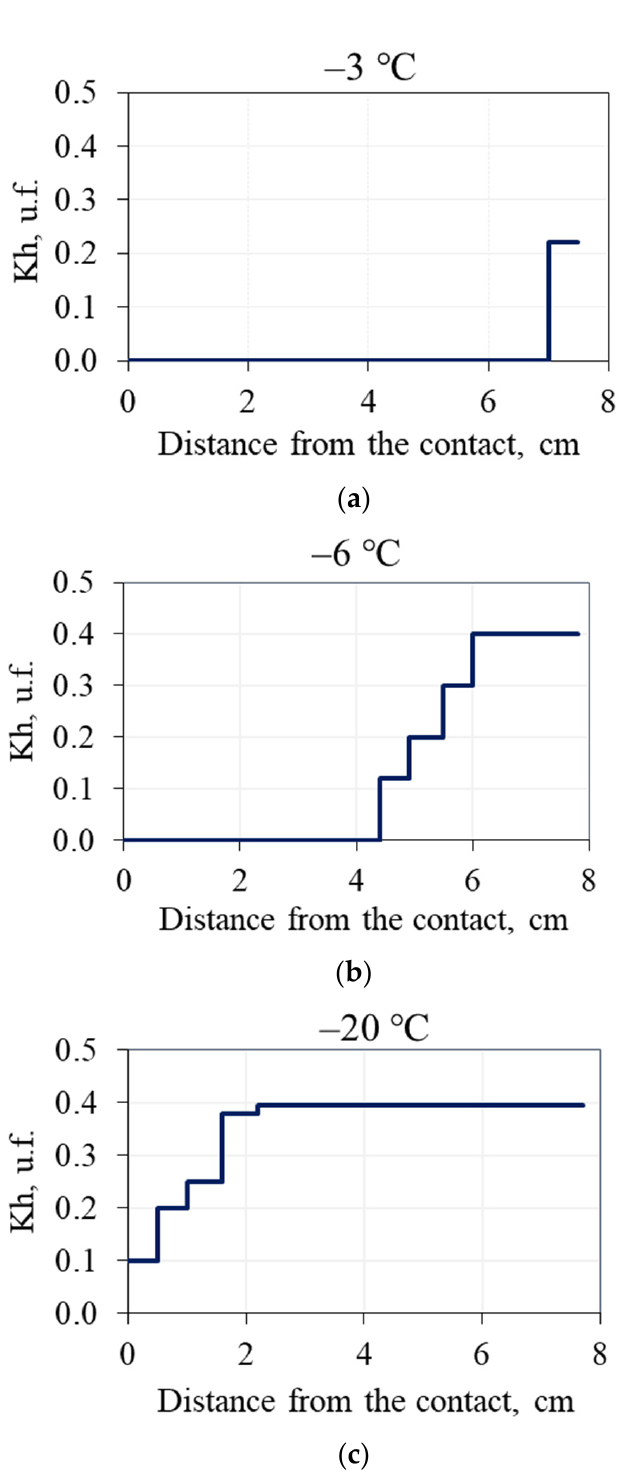
Figure 3. Variations of hydrate coefficient ( 𝐾 (cid:3035) ) along frozen hydrate-bearing sand samples ( 𝐾 ℎ𝑖𝑛 ~0.4, W = 12%) for 2 h of interaction with a 0.2 N NaCl solution at − 3 ( a ), − 6 ( b ), and − 20 °C ( c ). The calculated average Na + flux density for the applied experimental conditions showed a decreasing trend at lower temperatures (Figure 4): it was 58.10 − 10 mol/cm 2 at − 3 ◦ C, 20.10 − 10 mol/cm 2 at − 6 ◦ C, and only 5.10 − 10 mol/cm 2 at − 20 ◦ C (Figure